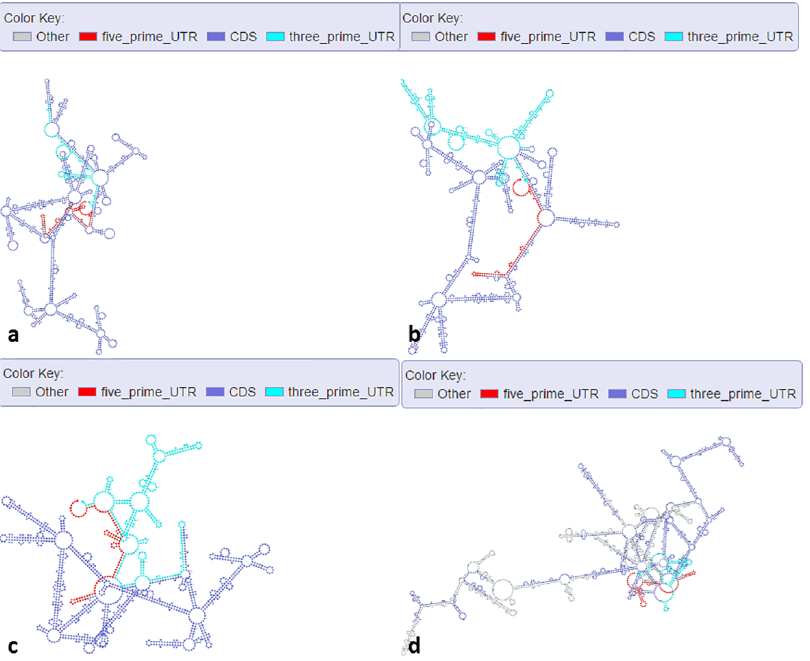
Fig 2. Secondary structure graphs of selected mRNA isoforms and un-spliced mRNA in Arabidopsis . (a) mRNA (Ensembl ID “AT4G27800.1”). (b) mRNA (Ensembl ID “AT4G27800.2”). (c) mRNA (Ensembl ID “AT4G27800.3”). D: un-spliced mRNA (Ensembl ID “AT4G27800.1”).